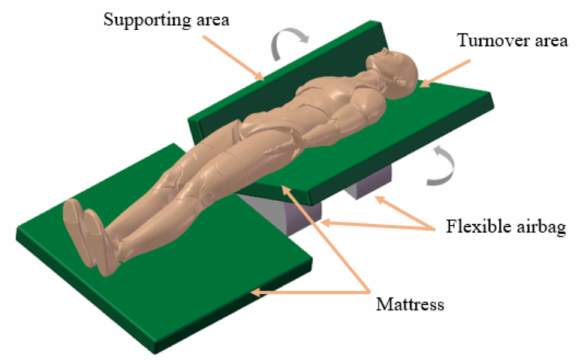
Figure 4. Schematic diagram of the